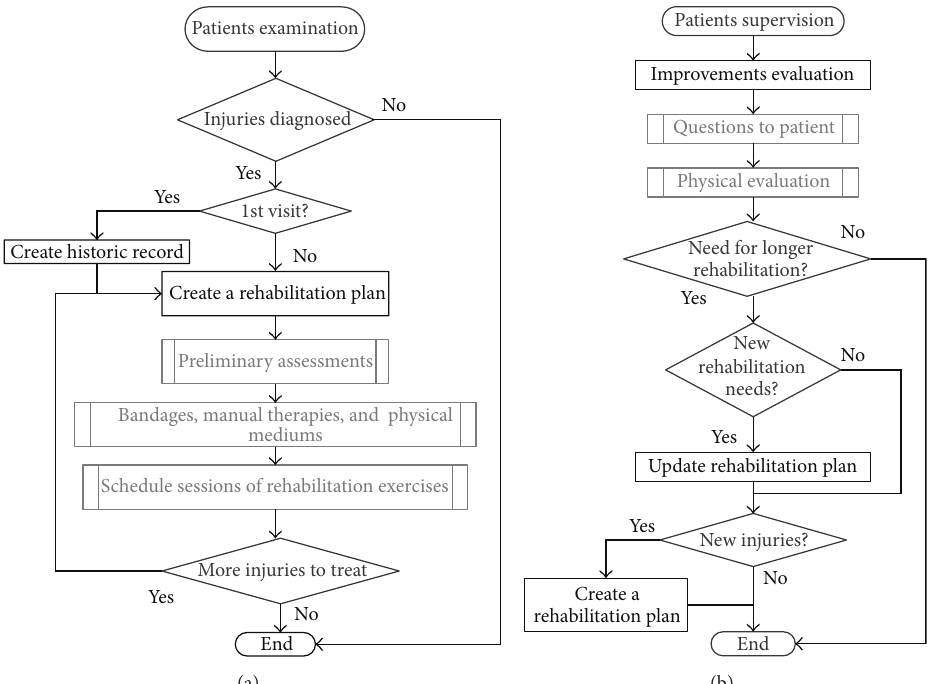
Figure 2: Flow diagram of rehabilitation attention processes. On the left, patient’s 1st examination and on the right, patient’s improvements